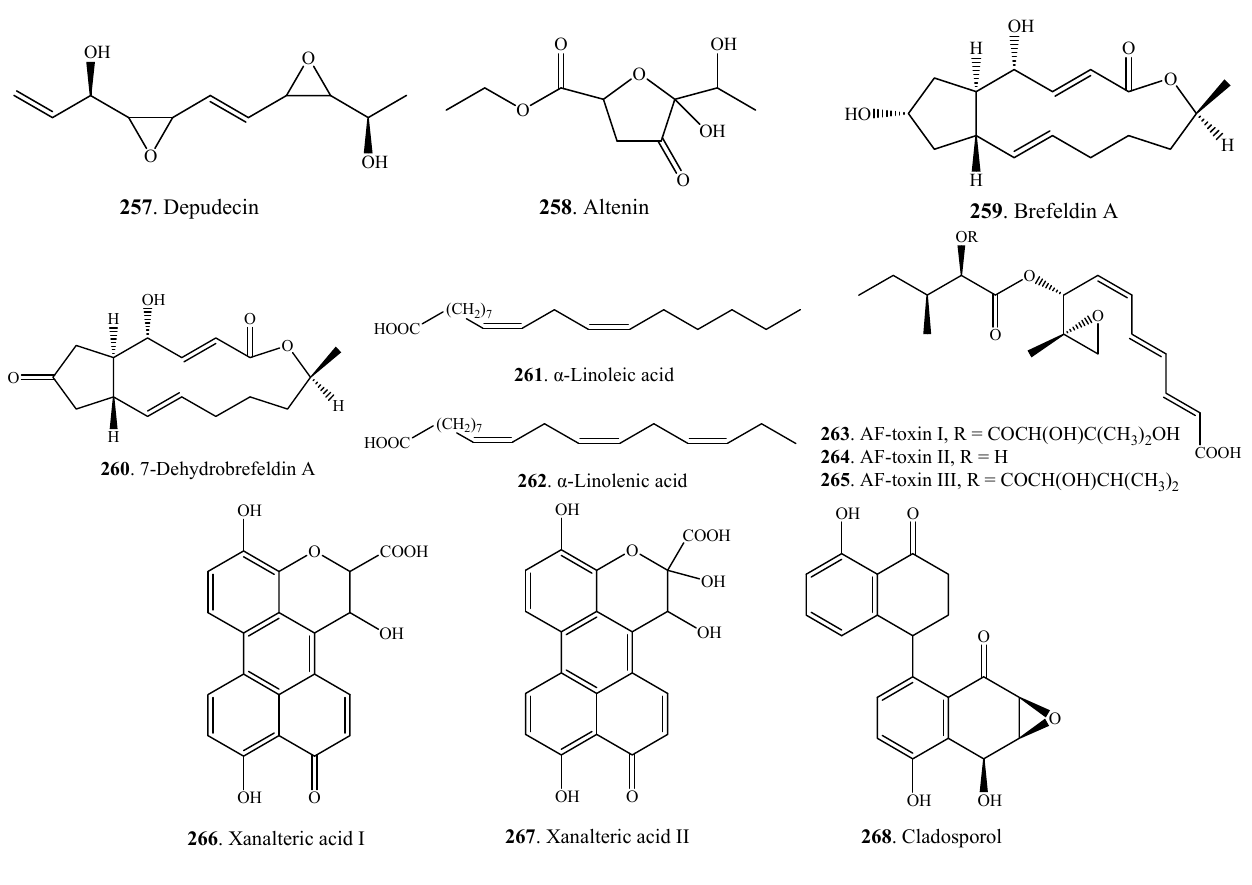
Figure 14. Miscellaneous metabolites isolated from Alternaria